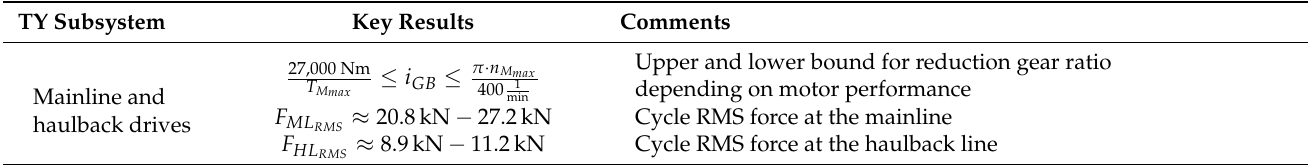
Table 10. Summary of the main results of Sections 4 and